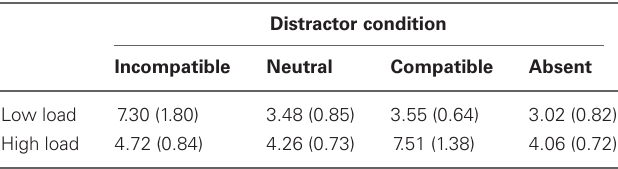
Table 1 | Percent error rates listed as a function of perceptual load and distractor condition in Experiment